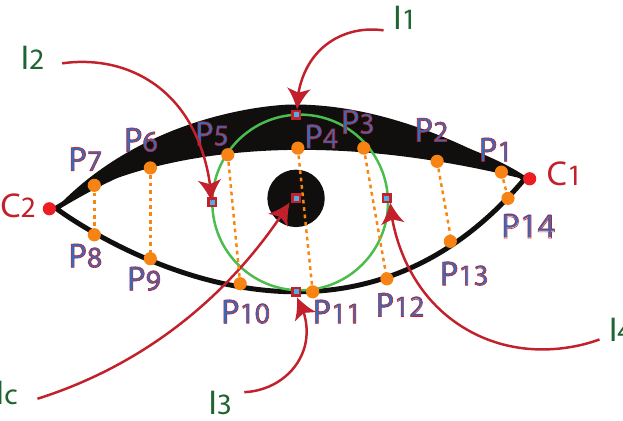
Figure 4. Eyelids and iris landmarks for MediaPipe Face